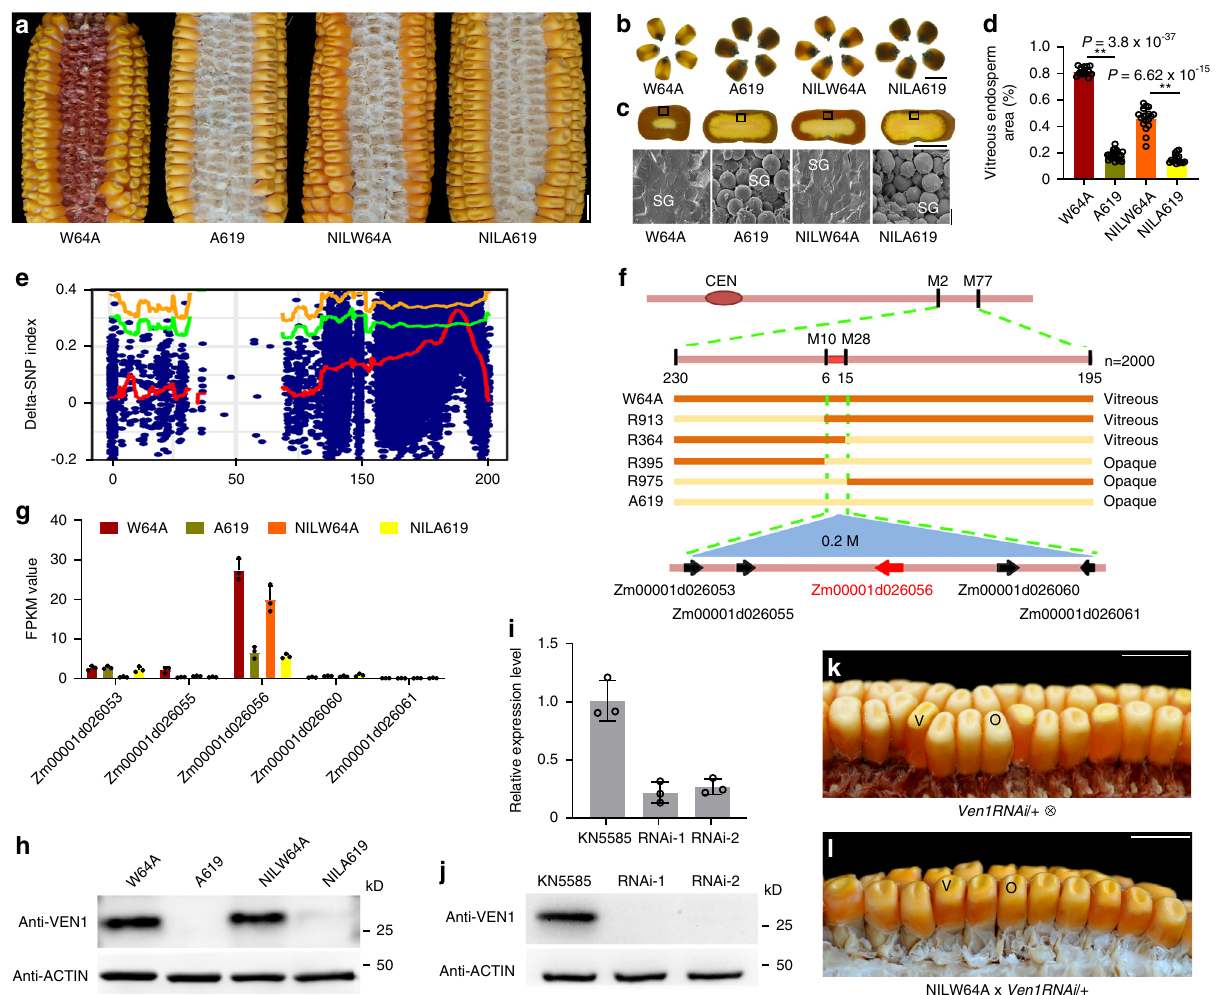
Fig. 1 Map-based cloning and genetic veri fi cation of Ven1 . a Ear phenotypes of W64A, A619, NILW64A and NILA619. Scale bar, 1 cm. b Kernel vitreousness as observed on the light box. W64A and NILW64A kernels are vitreous, and A619 and NILA619 opaque. Scale bar, 1 cm. c Kernel transverse sections of W64A, A619, NILW64A and NILA619. Top panel, the sections observed under the natural light. Scale bar, 5 mm; bottom panel, the areas boxed in the top observed by SEM. Scale bar, 10 μ m. SG, starch grain. d Measurement of the vitreous endosperm area in kernel transverse sections. Data are presented as mean values ± SD, n = 15, 23, 18 and 16, respectively. **, signi fi cant differences at P < 0.01 in two-sided Student ’ s t -test. e Mapping-by- sequencing of Ven1 . Delta SNP index of two pools of vitreous and opaque kernels segregated from F 1 BC 5 indicated a candidate QTL region in the long arm of chromosome 10. The red line is the mean value of SNP-index, green is the threshold line of 95% con fi dence level, and orange is 99% con fi dence level. f Fine mapping of Ven1 . Ven1 was located in a 0.2 Mb region between markers M10 and M28, containing fi ve genes. g Expression level of the candidate genes in 18-DAP endosperms of two parents and two NILs. The values are shown as the means ± sd of three biological replicates. h Immunoblotting analysis of VEN1 in seeds. ACTIN was used as an internal control. i qRT-PCR analysis of Ven1 in two independent transgenic lines. The values are shown as the means± s.d. of three biological replicates. Actin was used as an internal control. j Immunoblotting analysis of VEN1 in 18-DAP endosperms of two independent transgenic lines. ACTIN was used as an internal control. k Segregation of opaque kernels in a self-pollinated Ven1RNAi / + ear. l Ear phenotype of NILW64A x Ven1RNAi / + . Vitreous and opaque kernels segregated equally. k , l V, vitreous kernel; O, opaque kernel. Scale bar, 1 cm. The source data underlying d, g – j are provided as a Source Data fi seed set were obtained after propagating the transgenic seeds (Supplementary Fig. 5c). When NILW64A ears were fertilized by the pollen from heterozygous Ven1RNAi/ + plants, vitreous and opaque F 1 seeds segregated at a 1:1 ratio (Fig. 1l, Supplementary Fig. 5d). These genetic data showed that Zm00001d026056 is the gene responsible for the opaque endosperm phenotype in A619.